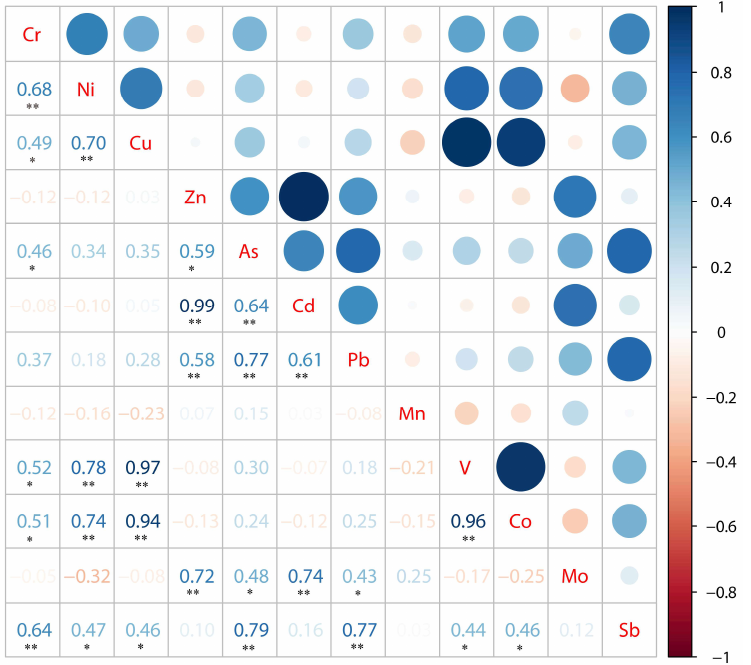
Figure 7. Pearson’s correlation coefficient matrix for heavy metal concentrations (** indicates that the correlation is extremely significant at the 0.01 significance level (two-tailed); * indicates that the correlation is significant at the 0.05 significance level (two-tailed).